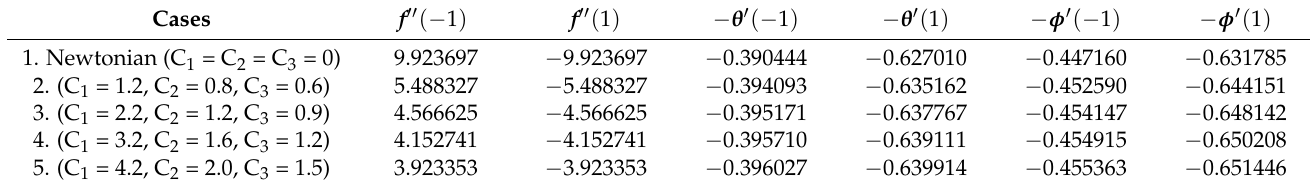
Table 3. Shear stresses, heat and mass transfer rates for various values of C 1 , C 2 & C 3 .